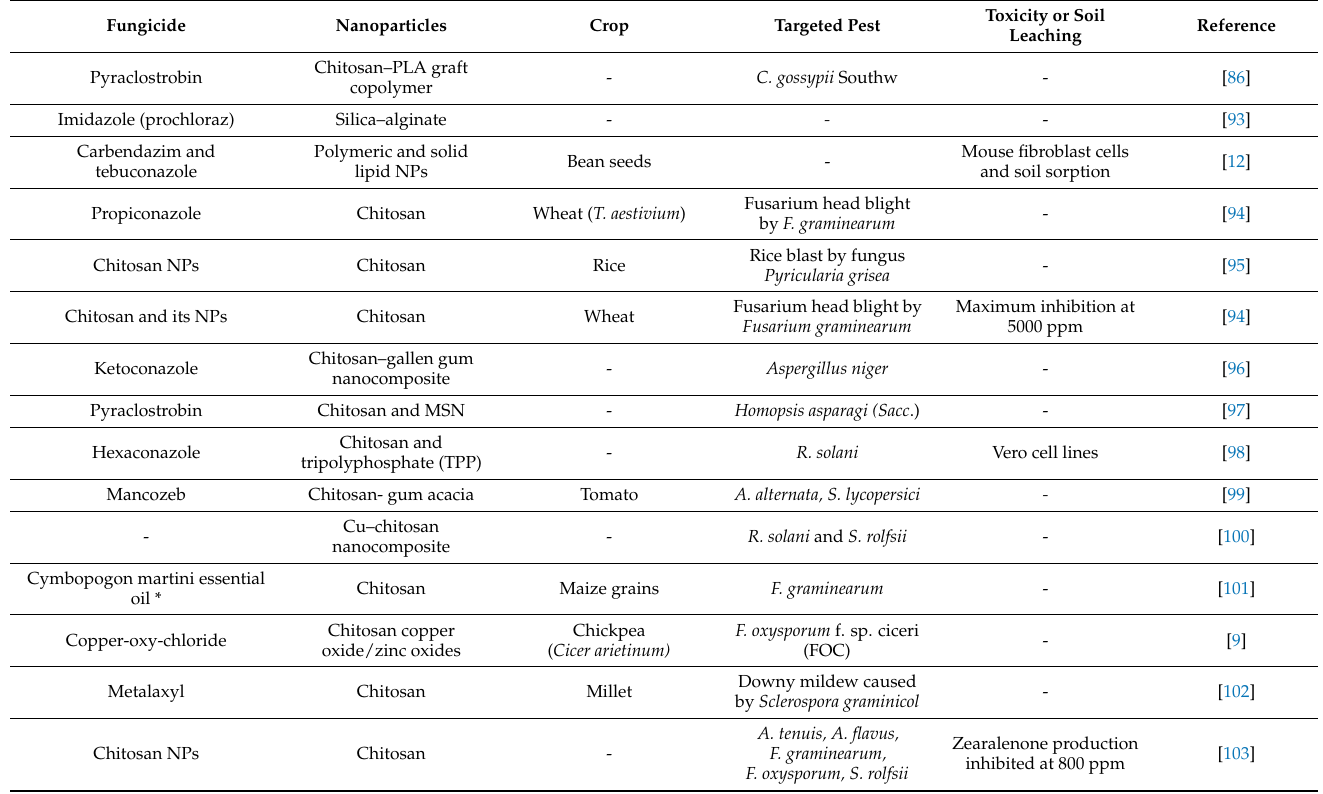
Table 2. Biopolymeric nanoparticle-based carriers of fungicides used to target pathogenic